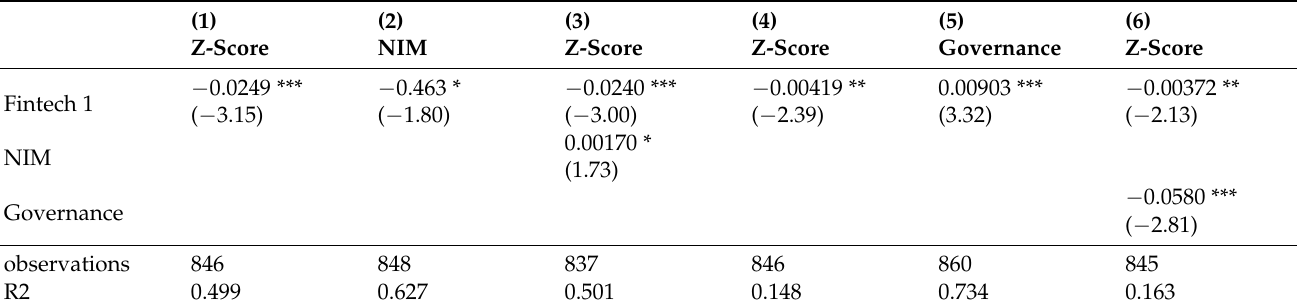
Table 13. Based on the intermediation effect test within the